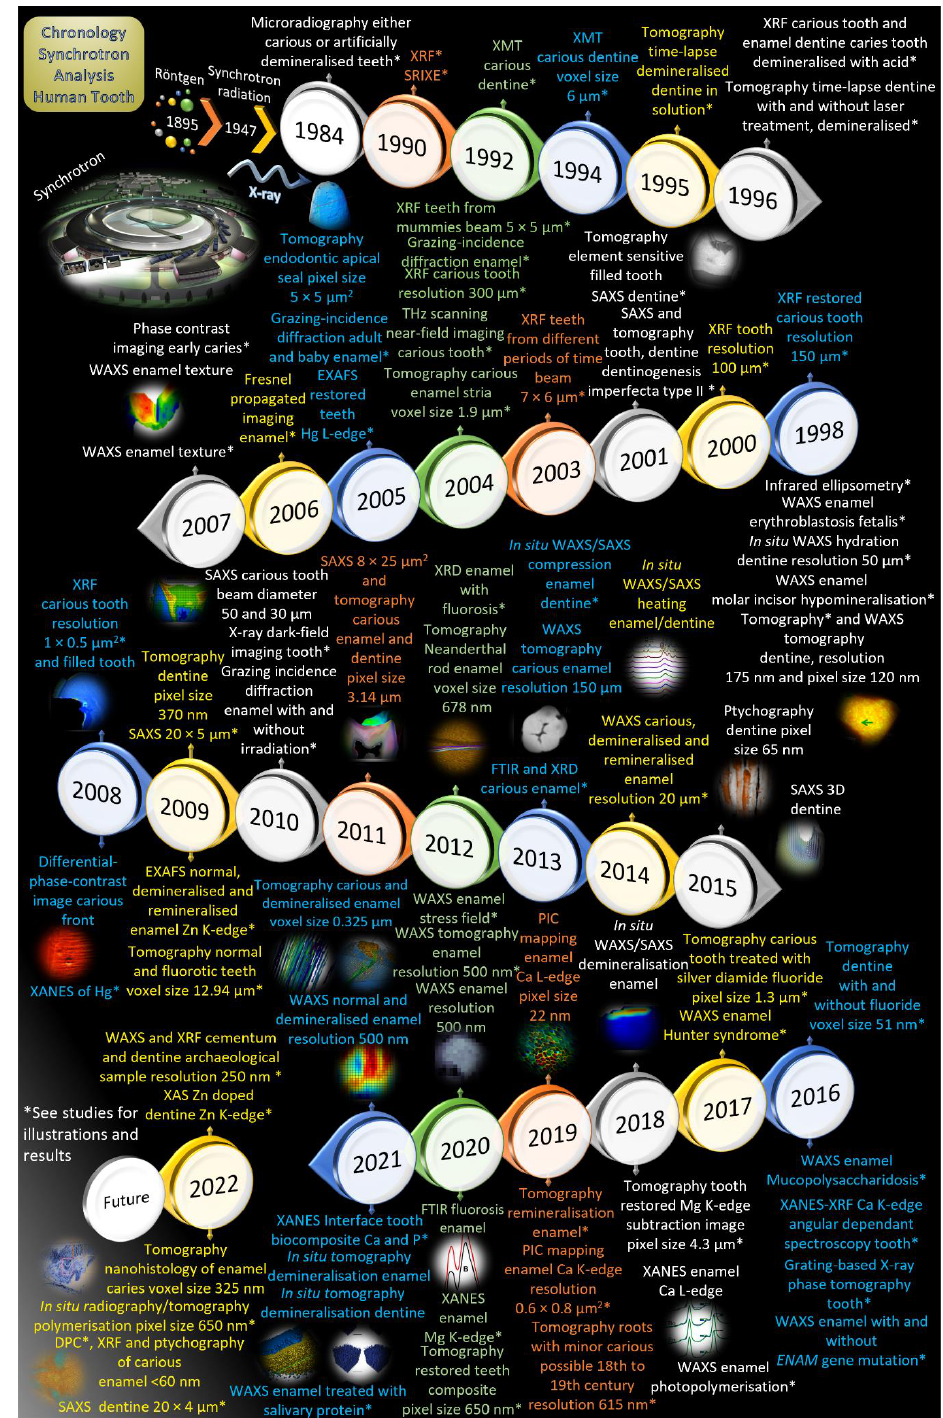
Figure 5. Timeline of the synchrotron studies carried out on human teeth. Timeline showing studies that have been performed on human teeth, with the details of some research done over the past decades covering different modalities and applications, e.g., WAXS, SAXS, tomog- raphy, X-ray fluorescence spectroscopy, and PIC mapping, the details in the figure are from these references [31,39,56,57,77,78,89,121,169–172,175,193,195,303,304,310,318,327,328,333,338,344, 348,349,353,354,361,363,368,372,376,380,385,392,399,403,404,407,412–414,416,419,420,423,425,442, 448,451,461,472,474,480,481,484,485,499,506,510,513,524,526,527,530,532,537–539,545,547–549,551– 553,555,556,560,561]. Furthermore, illustrations of some results are shown in chronological